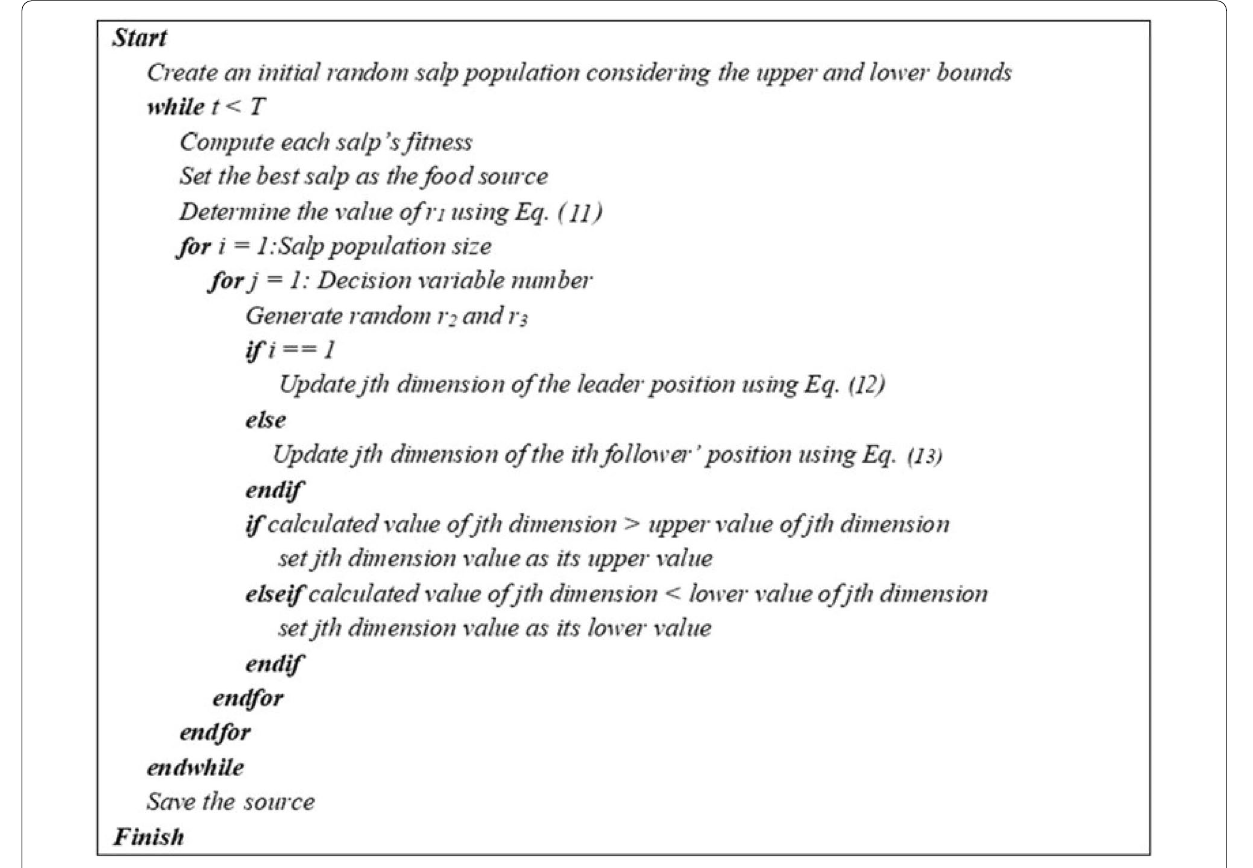
Fig. 8 Example of the pseudocode using